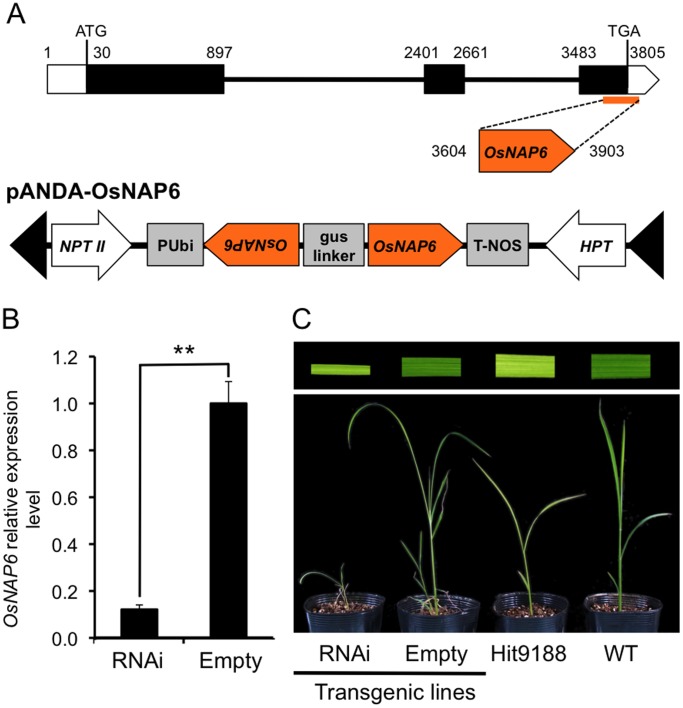
RNA interference confirms that the Os01g0127300 mutation is responsible for Hit9188 developmental phenotypes.(A) Structure of Os01g0127300 (OsNAP6) and scheme of the construct used for RNAi analysis targeting the OsNAP6 gene. (B) Results of real-time quantitative reverse transcription (RT)-PCR showing the relative expression level of OsNAP6 in rice plants transformed with OsNAP6-RNAi construct (RNAi) and empty vector (Empty). Asterisks indicate significant differences (Student’s t-test, **P<0.01). (C) Phenotype of leaf blade (top) and seedlings (bottom) of OsNAP6 RNAi transgenic plants compared to the Hit9188 mutant and Hitomebore wild-type (WT) plants.